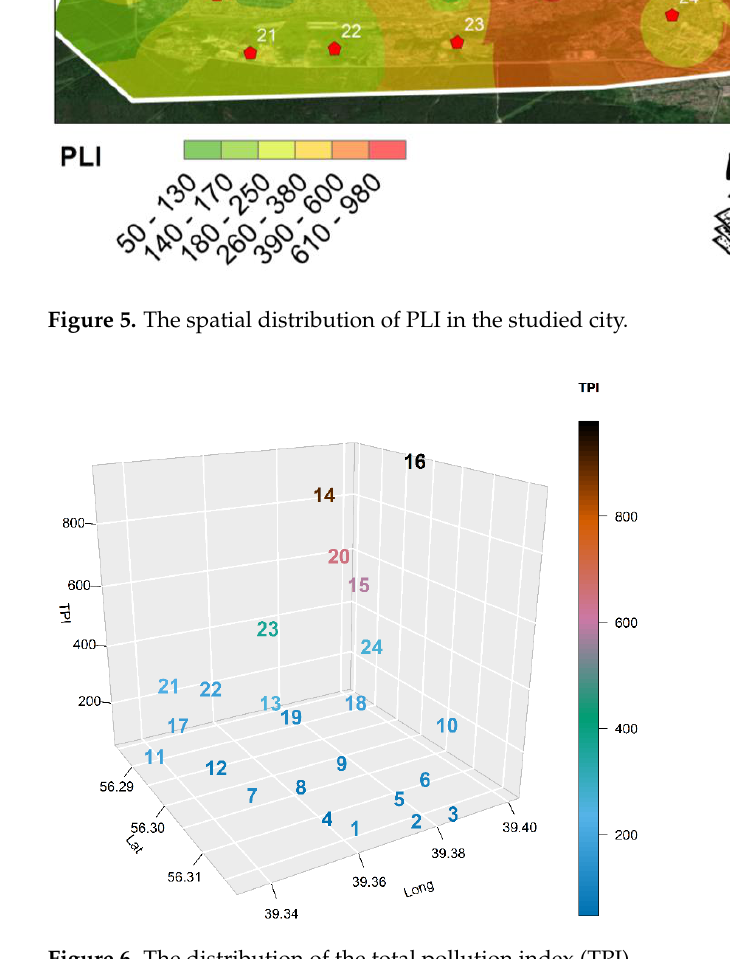
Figure 7. PER and the corresponding range for each category.